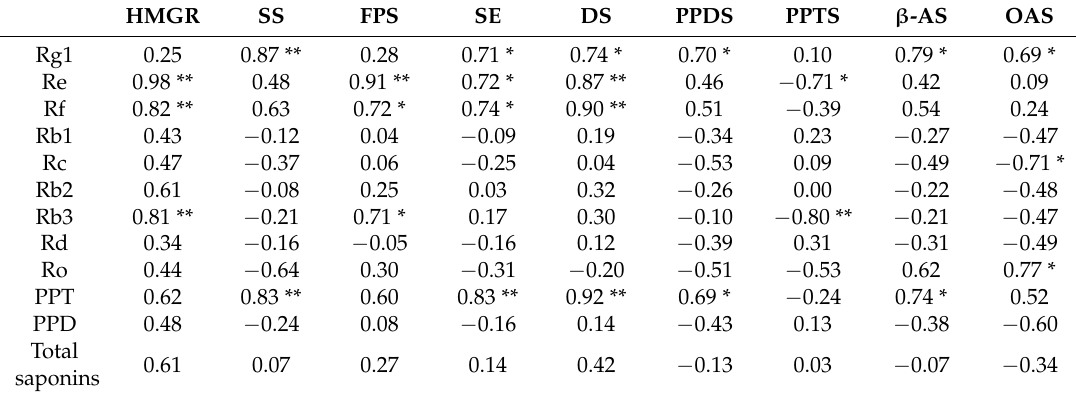
Table 11. Correlation analysis between gene expression and ginsenosides in roots at different growth times. HMGR SS FPS SE DS PPDS PPTS OAS